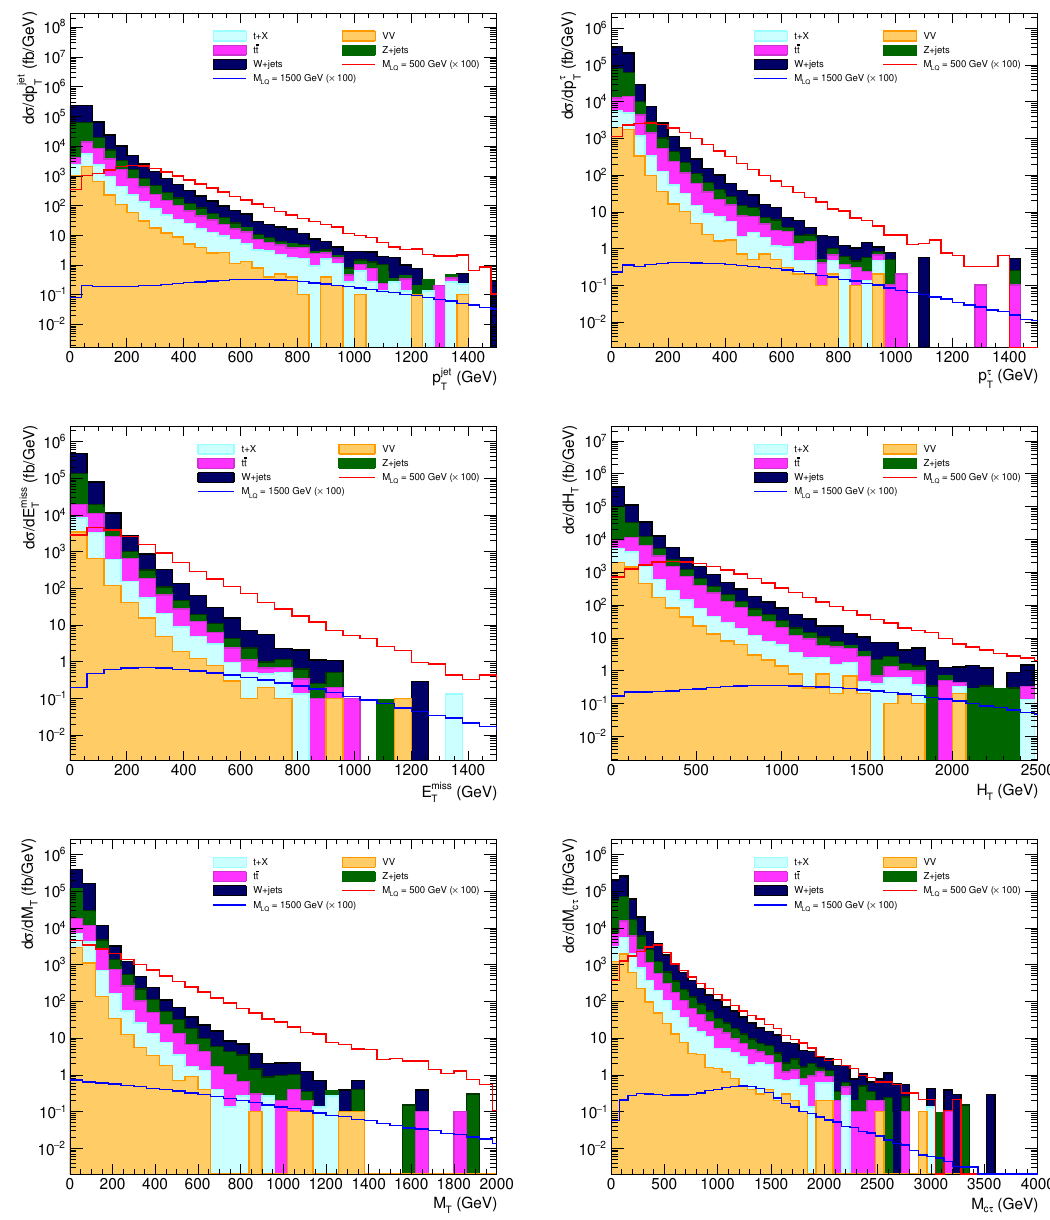
Figure 24 . Differential cross sections for the leading jet p T (top left), the leading tau p T (top right), the missing transverse energy (middle left), the scalar sum H T of all jet transverse momenta (middle right), the transverse mass M T of the leading tau lepton and the missing momentum (bottom left), and the invariant mass of the leading tau/leading jet system (bottom right). The distributions are shown for the di-boson ( V V , orange), single top (cyan), t ¯ t (magenta), Z + jets (dark green), and W + jets (navy) backgrounds, and for signal scenarios in which M S = 500 GeV (red) and 1500 GeV 1 (blue), M χ = 100 GeV and ∆ X = 0 . 5 0